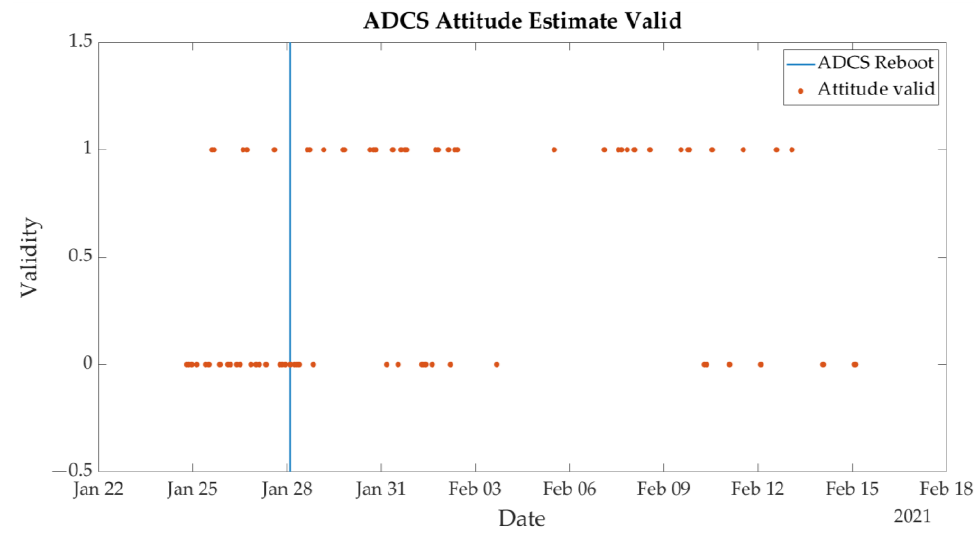
Figure 25. ADCS reboot count. 0 corresponds to invalid attitudes, 1 corresponds to valid